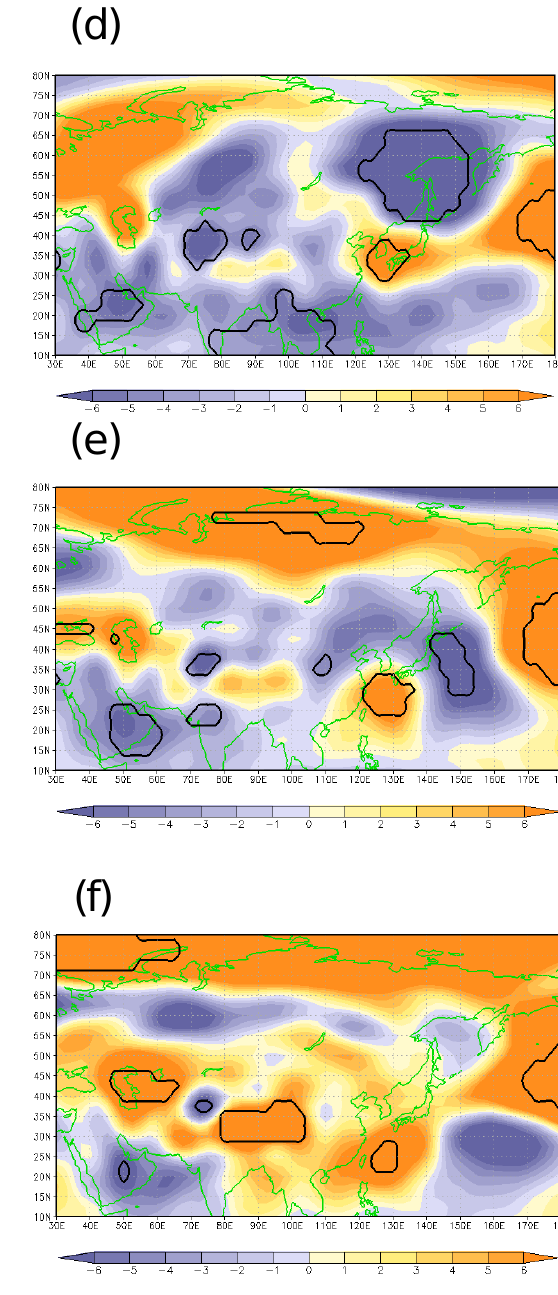
Figure 5. Composite differences in geopotential height (in m) at 850 hPa between hot and cool summer years in ( a ) NJJ, ( b ) NJP, ( c ) EJ, ( d ) WJ, ( e ) SIN, and ( f ) SIS. The borders of regions that reached a significance of 95% are shown with thick lines.